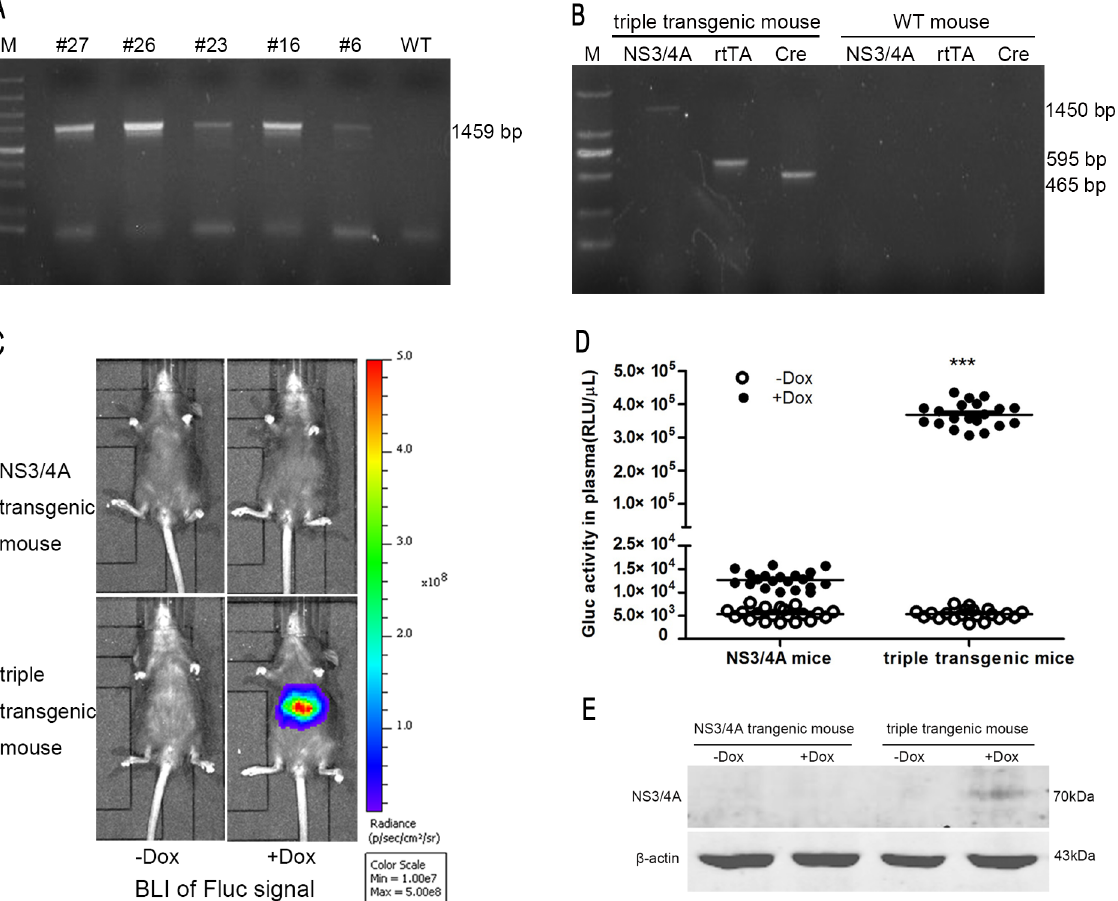
Fig 3. Generation and verification of the functionality of NS3/4A/Lap/LC-1 triple-transgenic mice. (A) PCR analysis of NS3/4A transgenic mice. M: DL 500 – 12,000; WT: wild type. (B) PCR analysis of triple-transgenic mice that contained the NS3/4A , rtTA and Cre transgenes. The results are representative of a single triple-transgenic mouse. M: DL 5000. (C) Representative BLI of Fluc signal. NS3/4A transgenic mice and triple-transgenic mice were induced with Dox (1 mg/mL Dox and 50 g/L sugar were dissolved in their drinking water) for 3 days. Then, the mice were intraperitoneally injected with D-luciferin and scanned using an IVIS imaging system. Non-Dox-induced NS3/4A transgenic mice and triple-transgenic mice were used as negative controls. (D) Gluc activity (shown in RLU) in the plasma of NS3/4A transgenic mice and triple-transgenic mice prior to and after Dox induction for 3 days (n = 20 mice/group). Each symbol represents an individual animal. The horizontal bars indicate group medians. *** = p < 0.001 compared to the negative control. (E) Representative western blot analysis. Liver homogenates from NS3/4A transgenic mice and triple-transgenic mice induced with Dox for 3 days were analyzed via western blotting using anti-NS3 and anti- β -actin